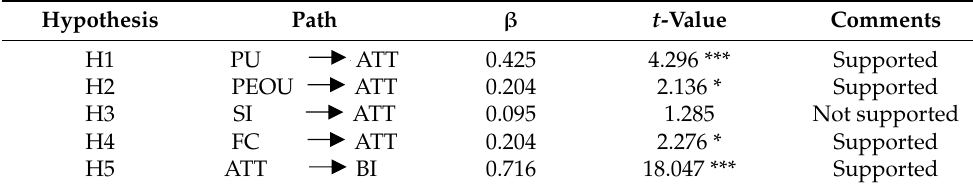
Table 6. Hypothesis analysis results.